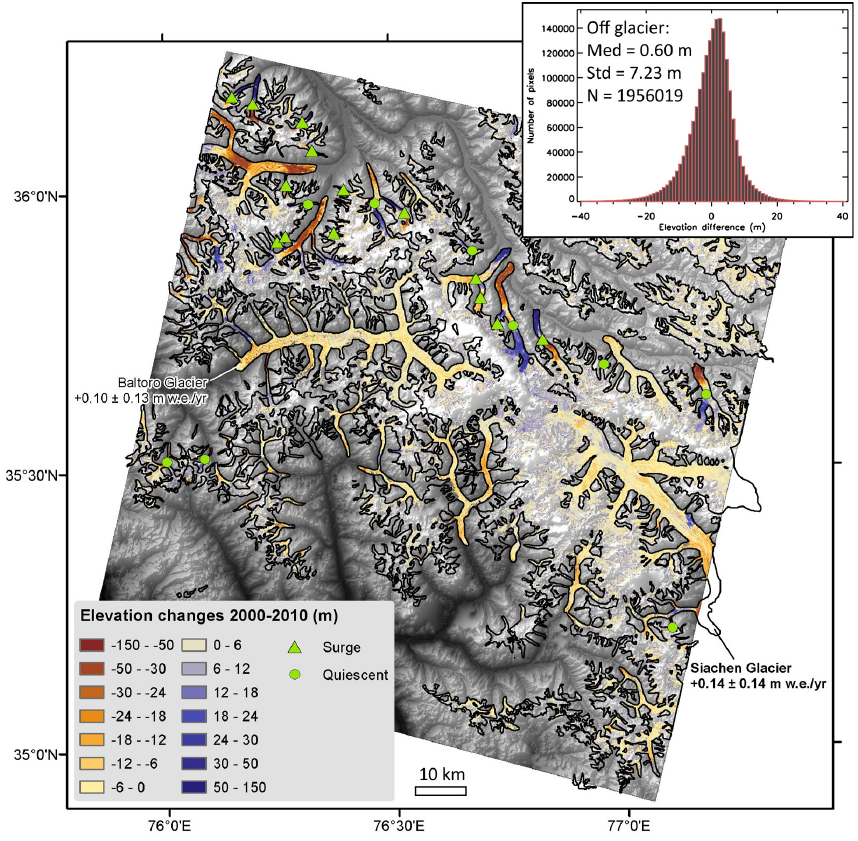
Fig. 8. Same as Fig. 2 but for the Karakoram east study site. Surge-type glaciers in an active surge phase (resp. quiescent phase) are identified with a solid triangle (resp. solid